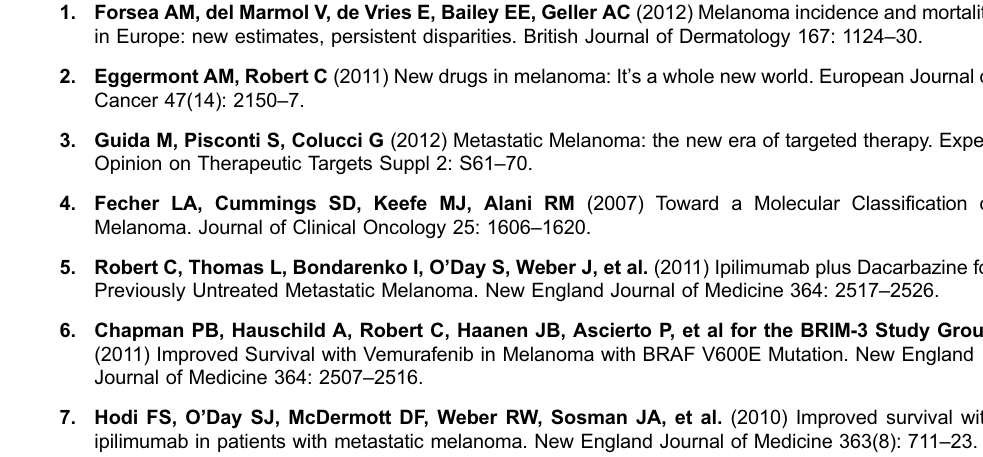
Table S3. Normalized data reporting cluster peaks’ expression in serum of TMZ treated patients at moment of DC (TRB) compared to time before treatment (T1B). Table S4. Normalized data reporting cluster peaks’ expression in serum of TMZ treated patients at progression time (TPB) compared to time before treatment (T1B). Table S5. Normalized data reporting cluster peaks’ expression in serum of Vemurafenib treated patients at established disease control time compared to baseline. Table S6. Normalized data reporting cluster peaks’ expression in serum of Vemurafenib treated patients at progression compared to